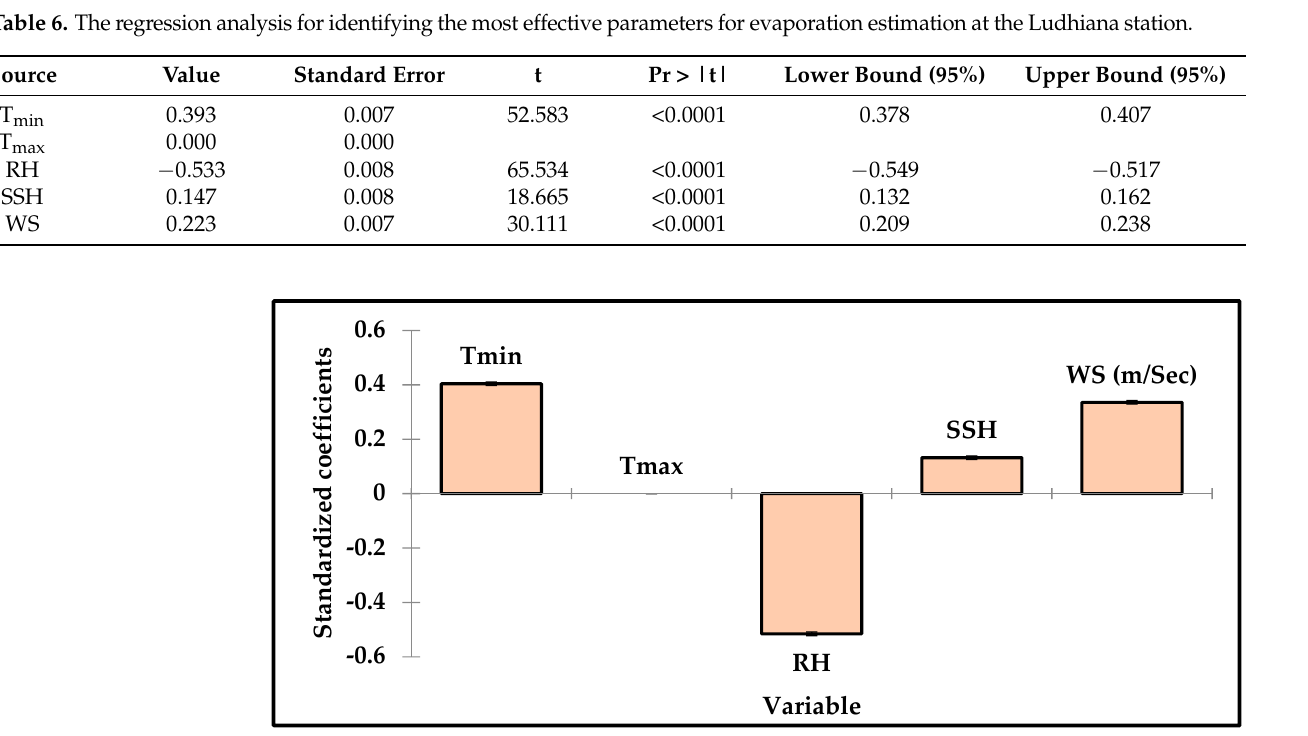
Figure 8. The standardized coefficients of input variable for sensitivity analysis at the Ludhiana station for evaporation. 3.2. Implementation of Meta-Heuristics Algorithm for Daily EP Estimation The pan evaporation at two different stations was estimated by applying four ma- chine learning algorithms (i.e., SVM, RT, REPTree, and RSS). The performances of the ap- plied algorithms were evaluated and compared based on performance indicators (i.e., MAE, RMSE, NSE, WI, and r). The model with a high value of NSE, WI, and r close to 1 and the lowest value of MAE and RMSE with close to 0 is considered the higher accuracy in the estimation of pan evaporation. The general trend of MAE, RMSE, NSE, WI, and r is presented in Tables 7 and 8. The SVM-4 model has the potential to estimate the pan evap- oration with greater accuracy as compared with other algorithms at both stations.